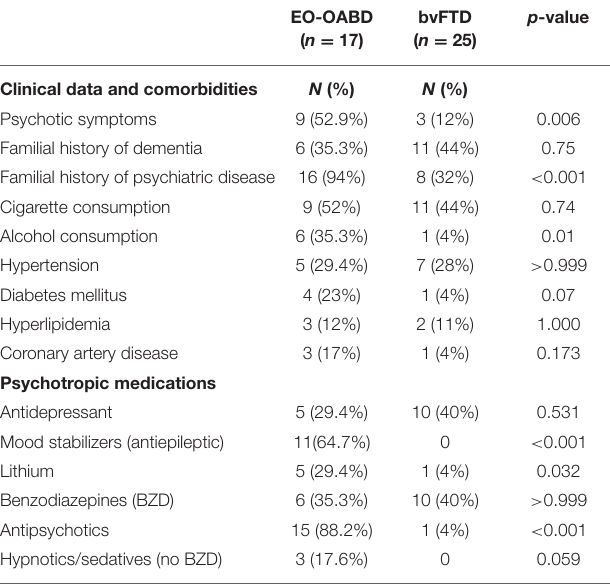
TABLE 2 | Comorbidities and psychotropic